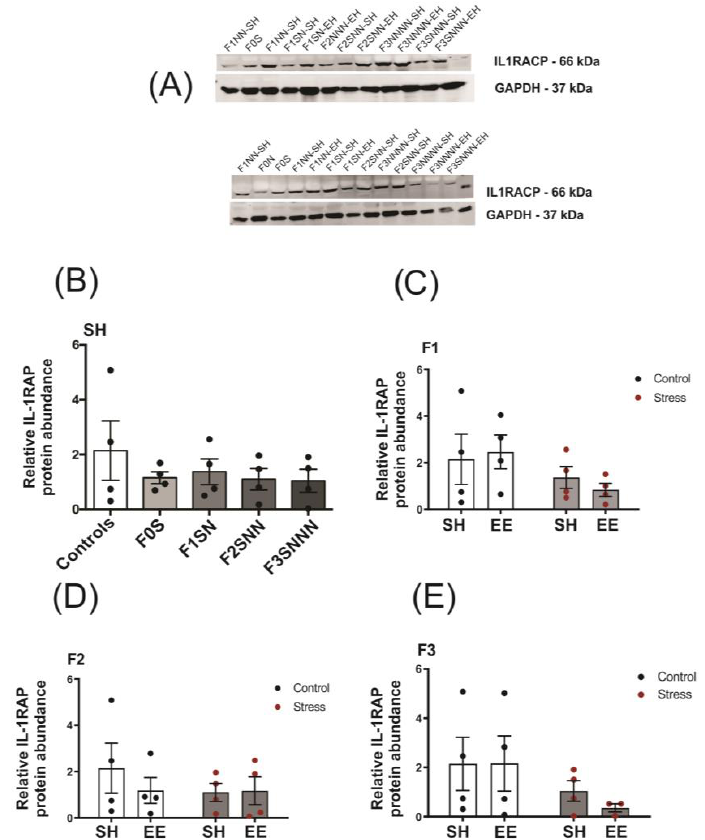
Figure 9. Uterine protein abundance of IL-1RAP remained unchanged over the stressed F0–F3 generations regardless of housing type. ( A ) IL-1RAP protein abundance quantified using densitometry (representative blots included). ( B ) Uterine protein abundance of IL-1RAP in F0–F3 stressed dams compared to controls. ( C – E ) IL-1RAP abundance according to treatment and housing across the F1–F3 offspring. Blots were quantitated using Odyssey software. All groups were compared using the Kruskal-Wallis test ( B ), and the effects of treatment and housing were assessed using two-way ANOVA ( C – E ). Data are normalized to glyceraldehyde 3-phosphate dehydrogenase (GAPDH) and compared to the F0N, mean ± SEM. N = 4 ( B ) or 3–4 ( C – E ). SH = standard housing; EE = enriched housing; F = filial generation; S = stressed; N = nonstressed.